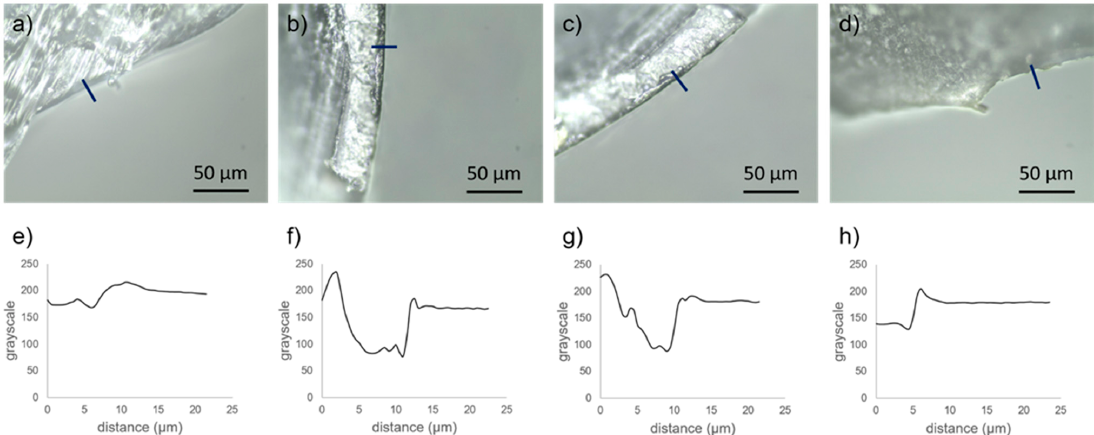
Figure 1. Optical micrographs of ( a ) PLA/PHA; ( b ) PLA/PHA+GNP0.05; ( c ) PLA/PHA+GNP; ( d ) PLA/PHA+AgNP. Blue lines depict the contrast profiles of pellets surface plotted for ( e ) PLA/PHA; ( f ) PLA/PHA+GNP0.05; ( g ) PLA/PHA+GNP; ( h ) PLA/PHA+AgNP. (PLA: Polylactic Acid; PHA: